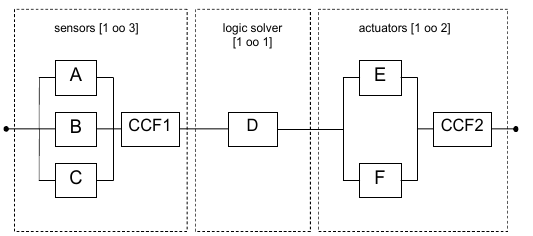
Figure 11. Reliability block diagram RBD of an example E/E/PE or SIS system structure.